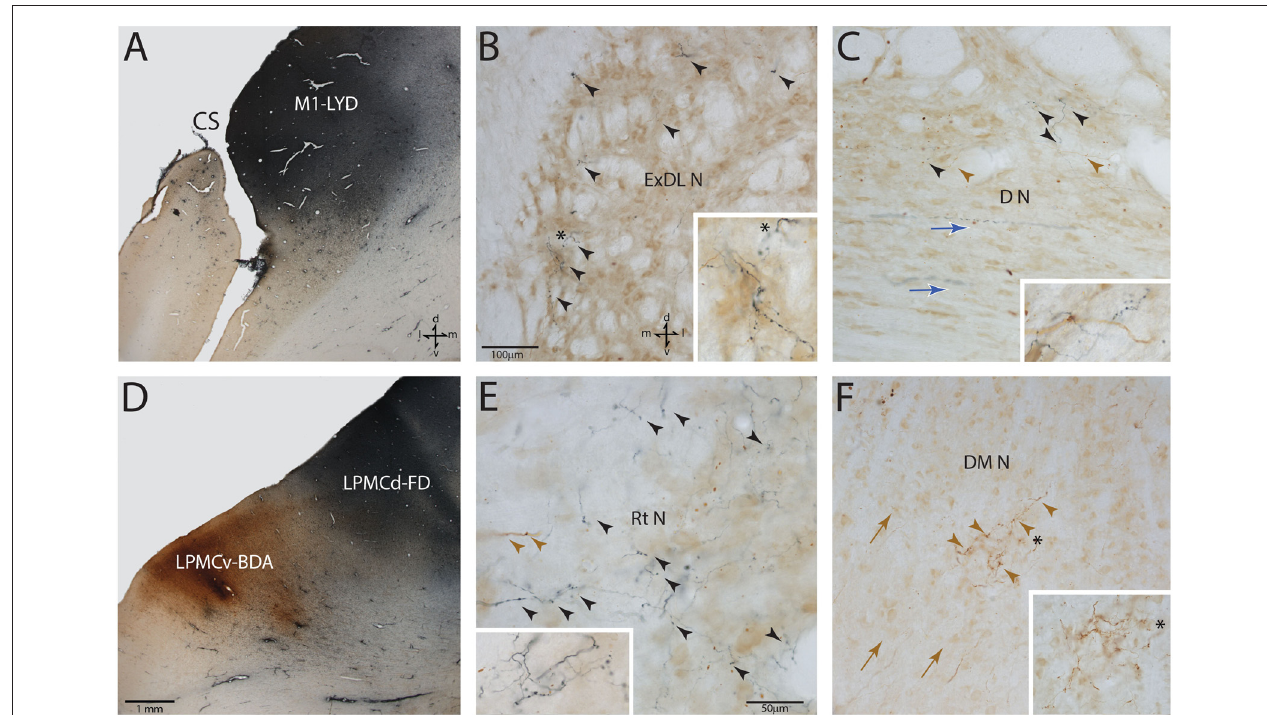
FIGURE 3 | Photomicrographic montage of representative examples of lateral motor area injection sites and labeled boutons in the contralateral PN taken from immunohistochemically developed tissue sections under brightfield microscopic illumination. (A) Coronal section through the LYD injection site (blue reaction product) placed in the arm representation of M1 in case SDM54. The anatomical orientation (bottom right) of this panel also applies to panel (D) . (B) Transverse section through inferior levels of the basis pontis in case SDM54 showing LYD labeled fibers and terminals (black arrowheads) in the contralateral extreme dorsolateral nucleus (ExDL N) following the LYD injection in the M1 arm/hand representation. The inset is a higher power micrograph from the terminal field in the main panel marked by the black asterisk. The anatomical orientation (bottom right) of this panel also applies to panels (C,E,F) . The micron bar (bottom left) applies to panels (C,F) . (C) Transverse section through lower levels of the pons in case SDM54 showing labeled terminals in the dorsal nucleus (D N) following an injection of LYD into M1 (blue reaction product and black arrow heads) and BDA into LPMCd (brown reaction product and brown arrowheads). The inset is from a different focal plane of the same section showing a BDA labeled fiber (brown) en passant, and LYD labeled terminal boutons (blue). The blue arrows show the pathway direction of labeled fibers passing through the dorsal nucleus en route to the more laterally located dorsal tier nuclei (i.e., to the dorsal lateral nucleus and extreme dorsolateral nucleus). (D) Low power image depicting the FD (blue reaction product) and BDA (brown reaction product) injection sites in LPMCd and LPMCv, respectively in case SDM57. The calibration bar in the bottom left of the panel also applies to panel (A) . (E) Transverse section though mid-levels of the pontine gray matter in case SDM57 showing BDA terminal boutons (brown arrowheads) and LYD labeled terminal boutons (black arrowheads) in the contralateral reticular nucleus (Rt N). The inset is from a different focal plane of the same tissue section showing a terminal cluster of LYD labeled axons and terminals. (F) Transverse section through mid-levels of the basis pontis in case SDM57 showing BDA labeled terminals (brown arrowheads) in the contralateral dorsal medial nucleus (DM N). The inset is a higher power micrograph from the terminal field in the main panel marked by the black asterisk. The brown arrows show the dorsolateral trajectory of labeled fibers passing through the dorsomedial nucleus en route to the laterally located dorsal tier nuclei (i.e., dorsal nucleus, dorsal lateral nucleus and extreme dorsolateral nucleus). Abbreviations: cs, central sulcus; d, dorsal; l, lateral; LPMCd, dorsolateral premotor cortex; LPMCv, ventrolateral premotor cortex; m, medial; M1, primary motor cortex; v, ventral. For other abbreviations see Figure 2